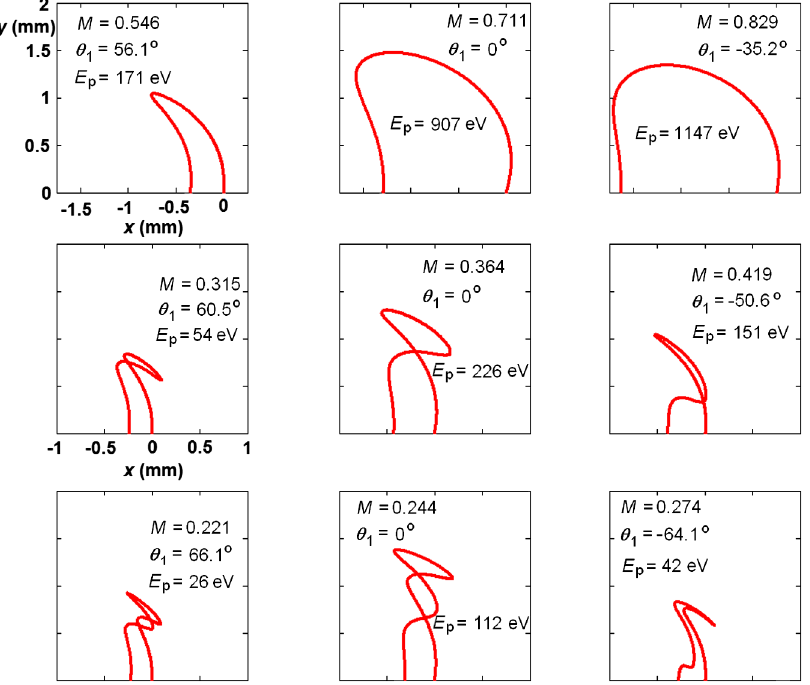
FIG. 12. Examples of orbits for the first three zones of MP1. The upper row is for n ¼ 1 . Compare values of M at q ¼ 0 : 58 with Fig.